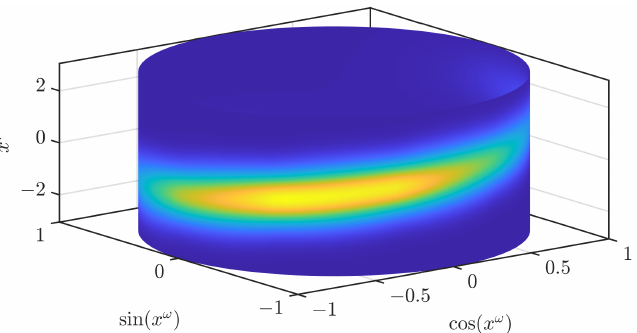
Figure 4. Continuous density obtained by the use of a trigonometric polynomial for the periodic part and distance-based mixtures of Gaussians for the linear